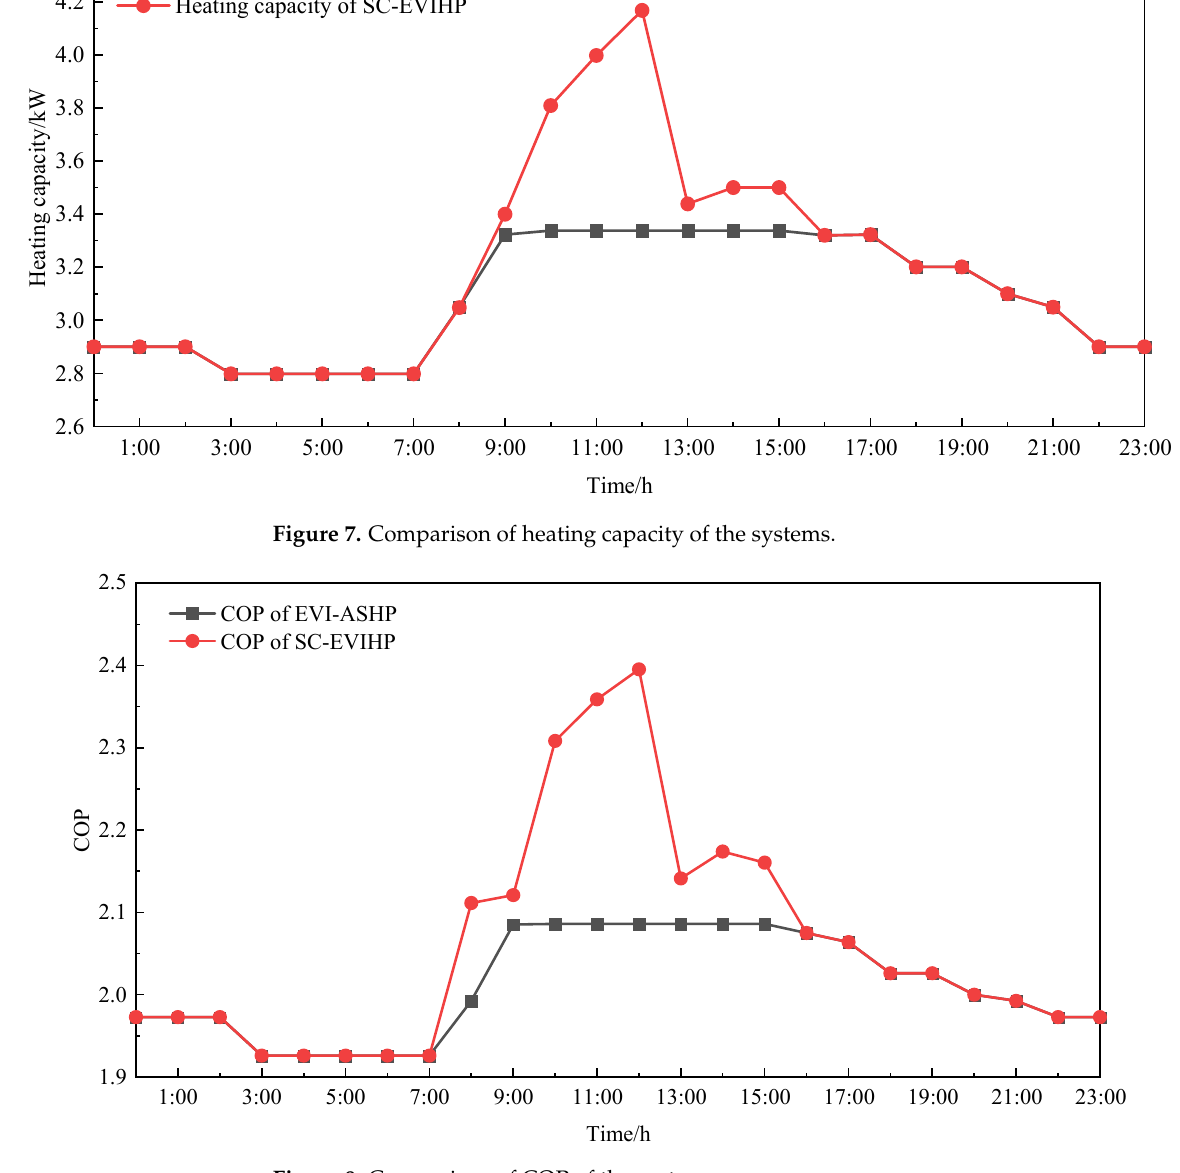
Table 3. Operational performance of the EVI ‐ ASHP system at different outdoor temperatures.